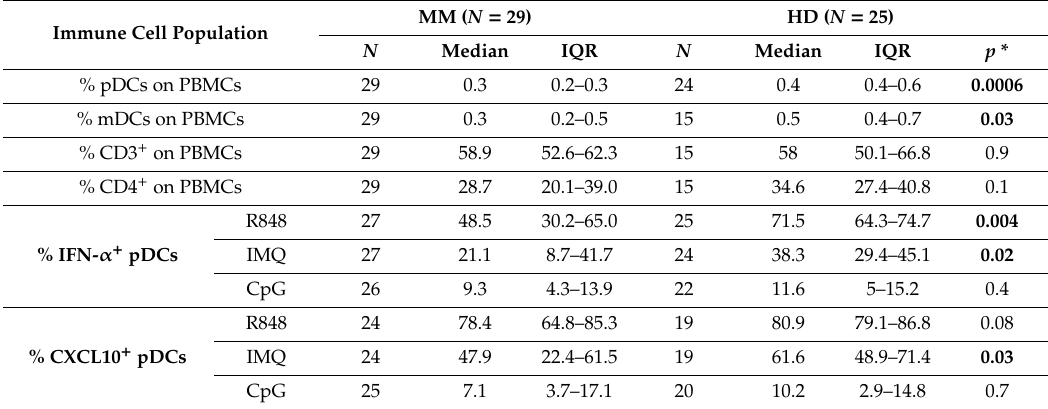
Table 2. Peripheral blood immune populations in healthy donors (HD; N = 25) and metastatic melanoma (MM) at baseline (T0; N =